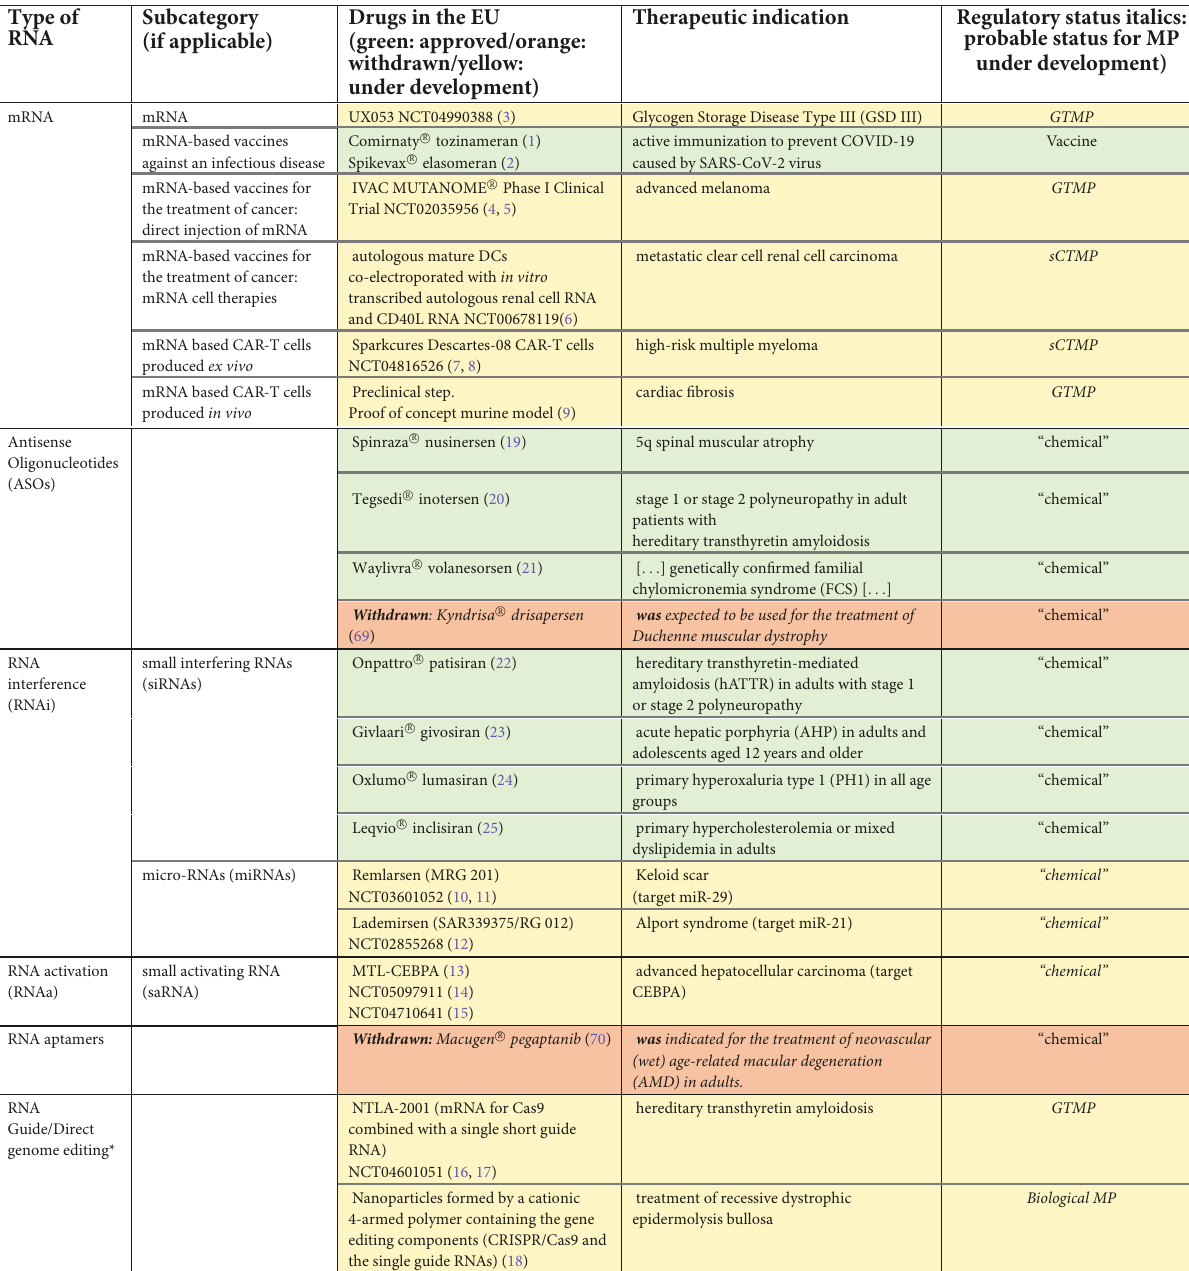
TABLE 1 Examples of RNA-based drugs currently or formerly on the market or under